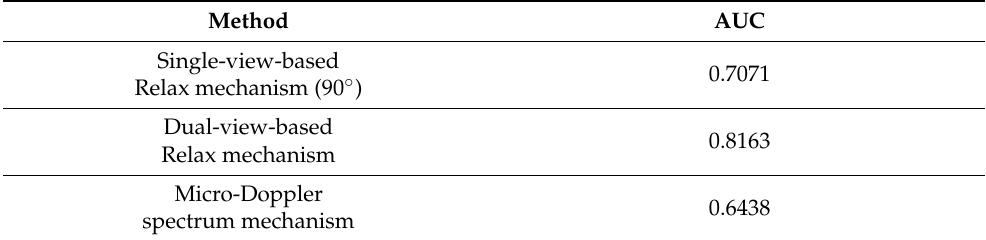
Table 6. AUC obtained from three different